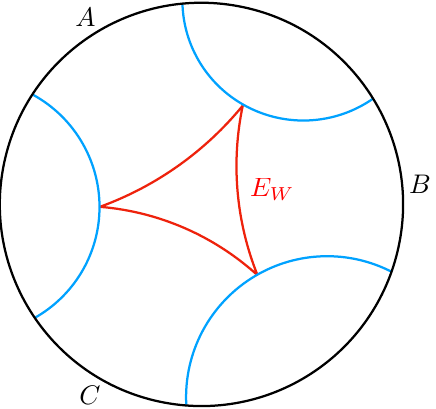
Figure 2 . The tripartite entanglement wedge cross section (red line) of the ABC boundary sub- system, with area E W . Note that the minimization here is a constrained minimization such that the red line must separate A , B , and C from their respective complements in the entanglement wedge and be